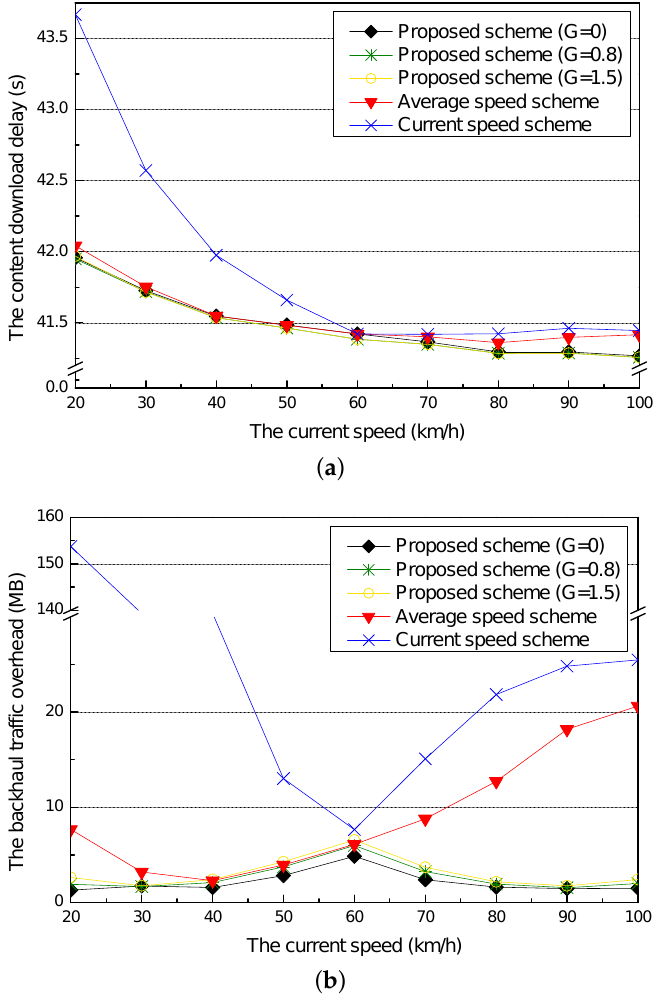
Figure 11. Simulation results for different current speeds: ( a ) the content download delay and ( b ) the backhaul traffic